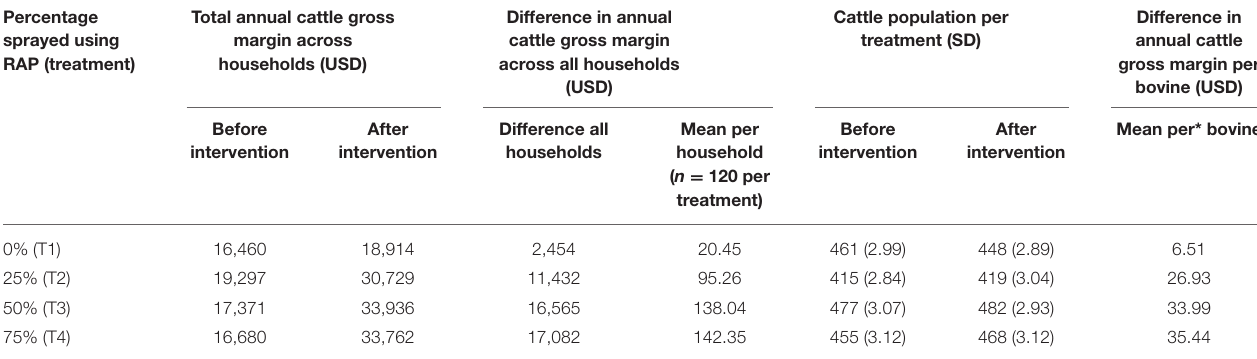
TABLE 4 | Annual cattle gross margin and benefit from using RAP compared to control. Percentage sprayed using